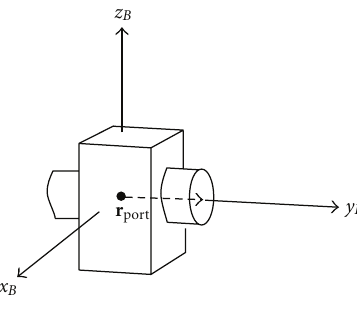
Figure 8: Body fixed docking port